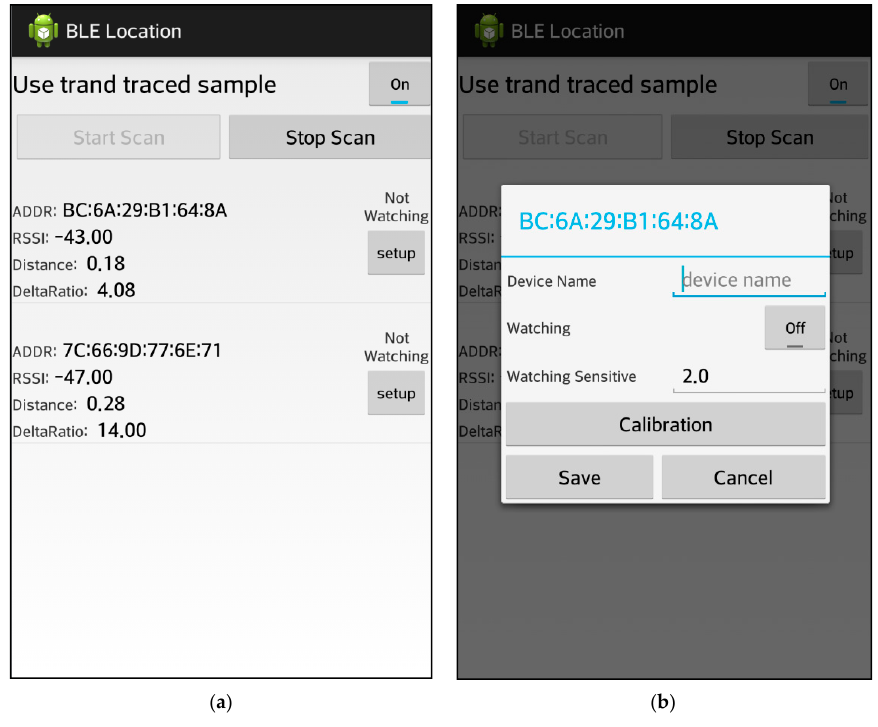
Figure 16. Position Measuring Application (Scenario 2). ( a ) User Interface (1); ( b ) User Interface